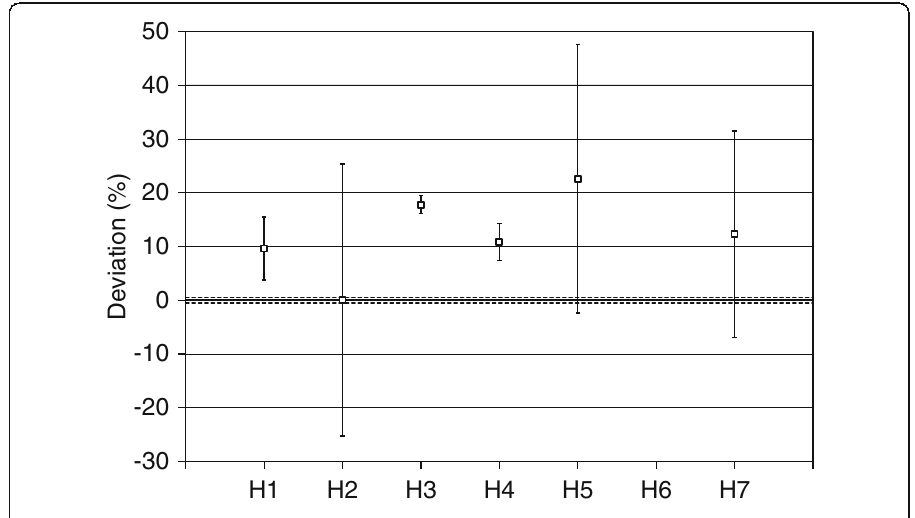
Fig. 8 Participants reported activities for the entire comparison